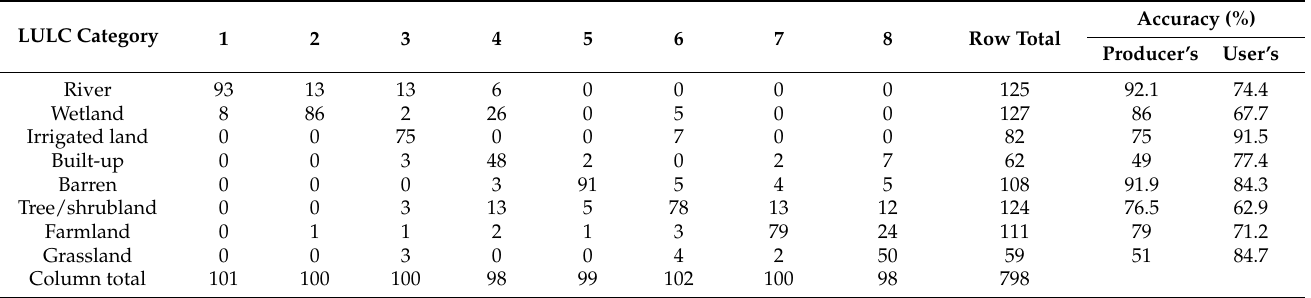
Table 7. Confusion matrix for Sentinel 2, 1 (VH backscatter) and SRTM elevation data (Scenario